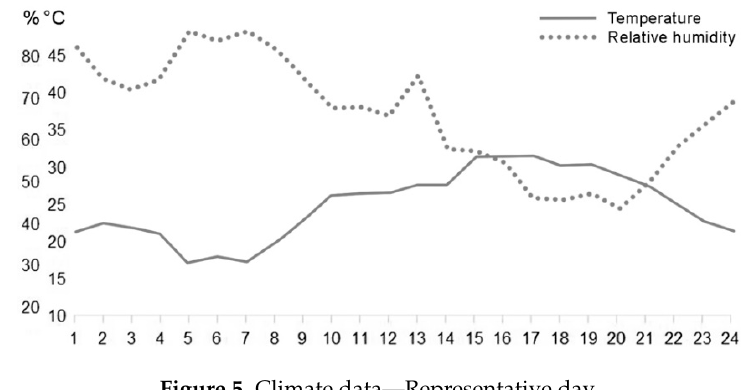
Figure 5. Climate data—Representative day. Energies 2017 , 10 , 351